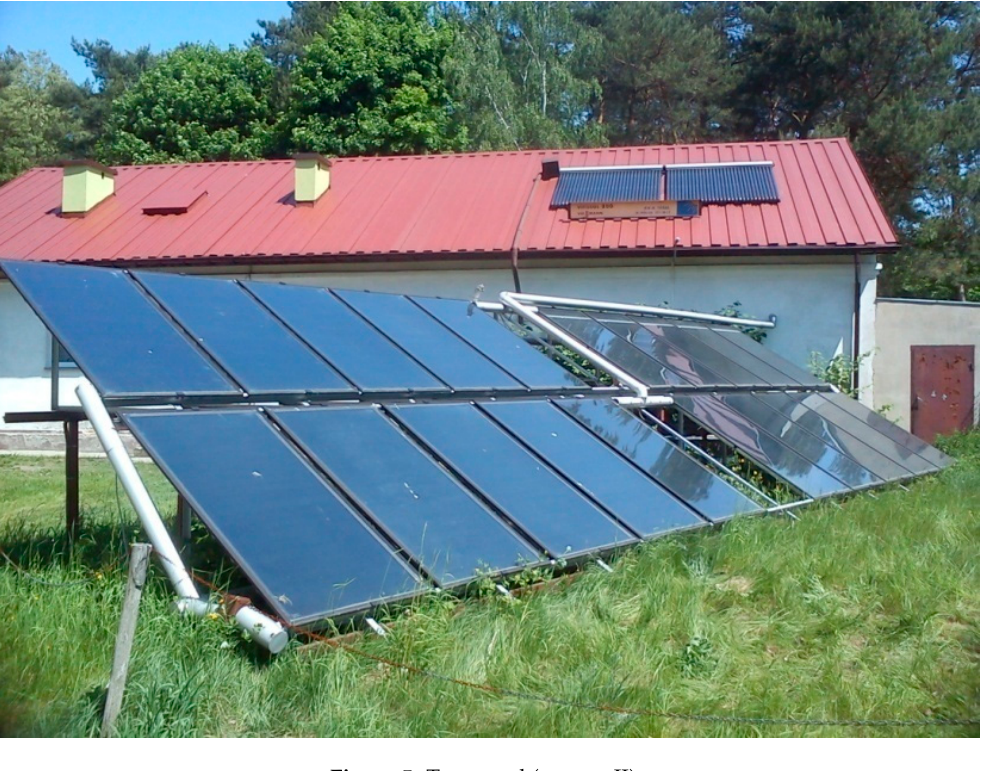
Figure 5. Test stand (system II).